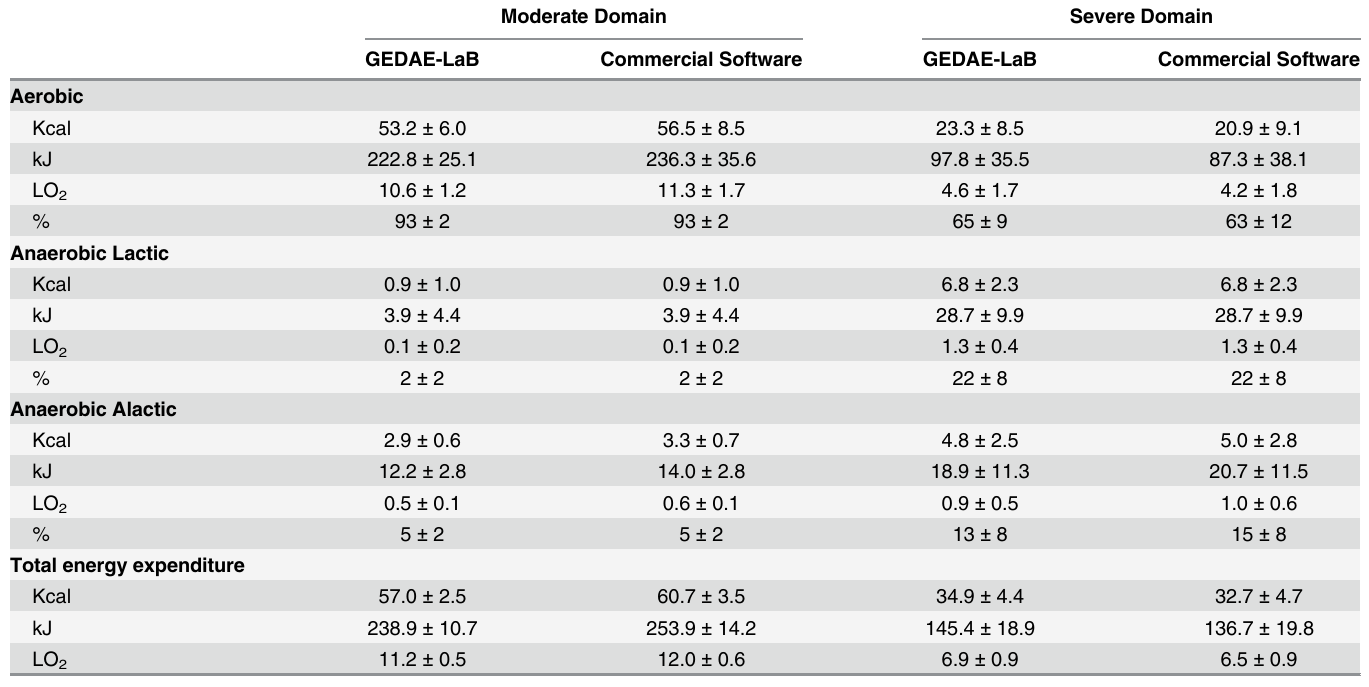
Table 3. Comparison of the energy system contributions and total energy expenditure determined by GEDAE-LaB and commercial software (n =